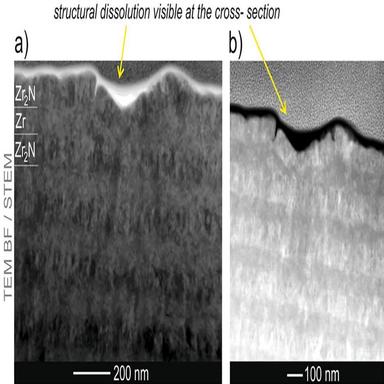
A cross-section image showing the anodic dissolution in the Zr/Zr2N (1:1 ratio) multilayer coating performed by TEM; a) TEM BF image; and b) STEM image.